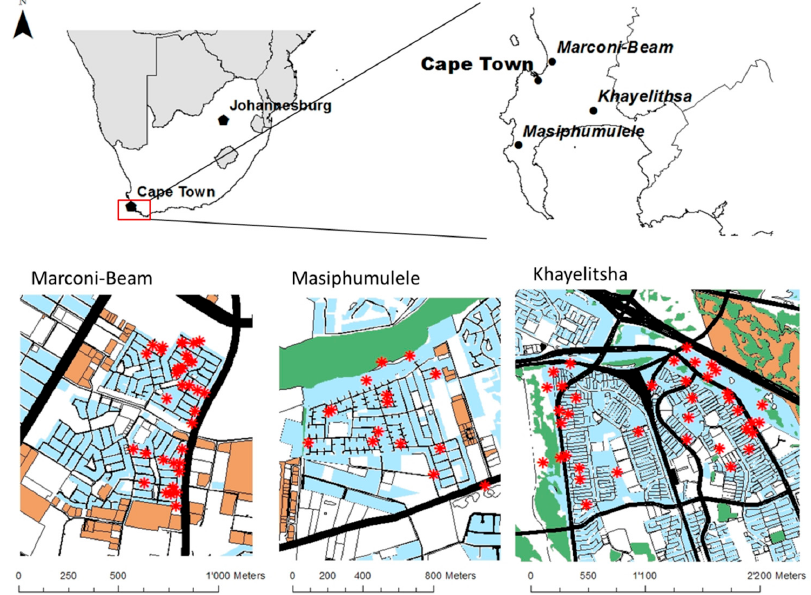
Figure 1. Overview of the three monitoring areas, Western Cape, South Africa. The measurement sites are represented with red stars, the roads as black lines, urban area in light blue, industrial area orange, and vegetation in green.